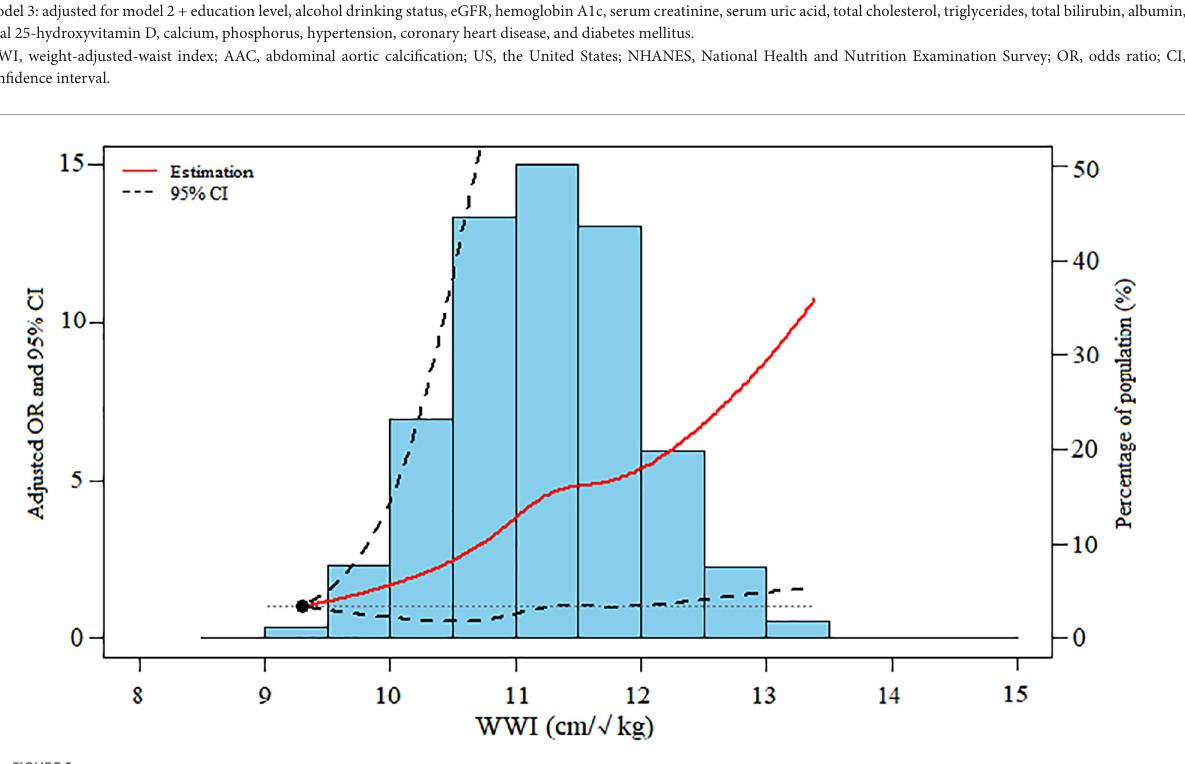
√ kg as the reference. WWI, weight-adjusted-waist index; AAC, abdominal